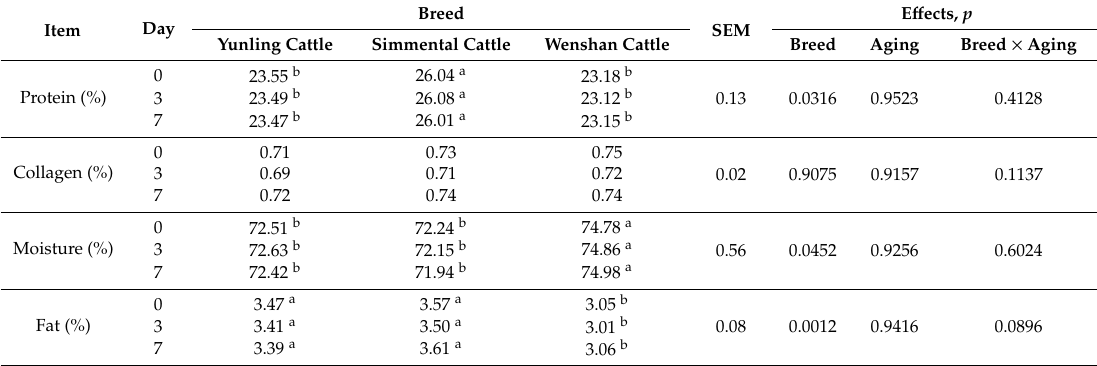
Table 2. The chemical composition of Yunling, Simmental and Wenshan beef during aging.